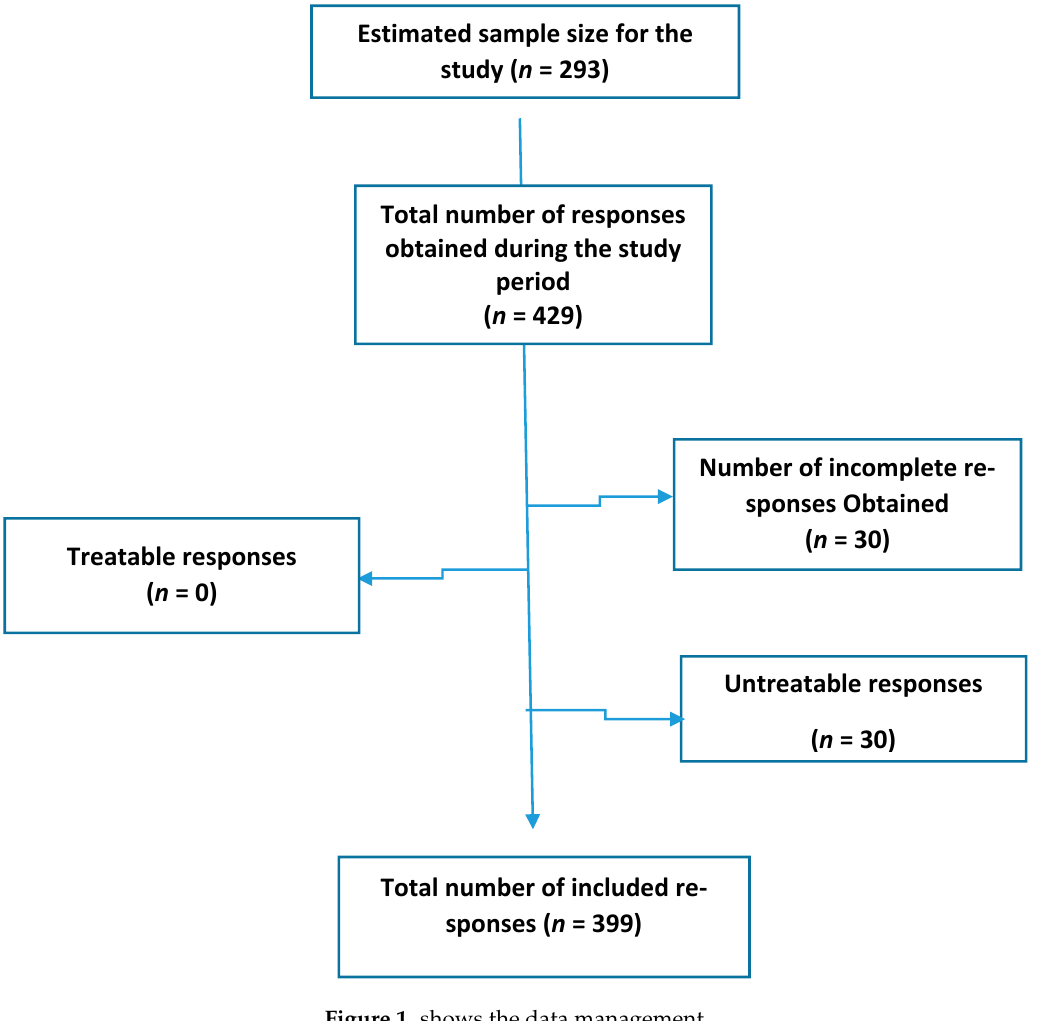
Figure 1. shows the data management.